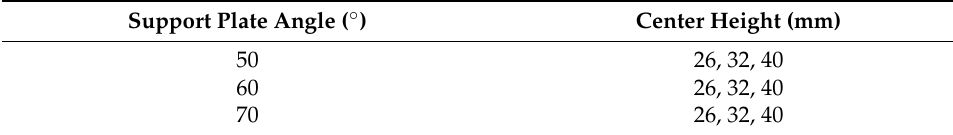
Figure 2. Schematic diagram of center height and the support plate angle. Table 1. Values of centerless grinding experiment parameters.